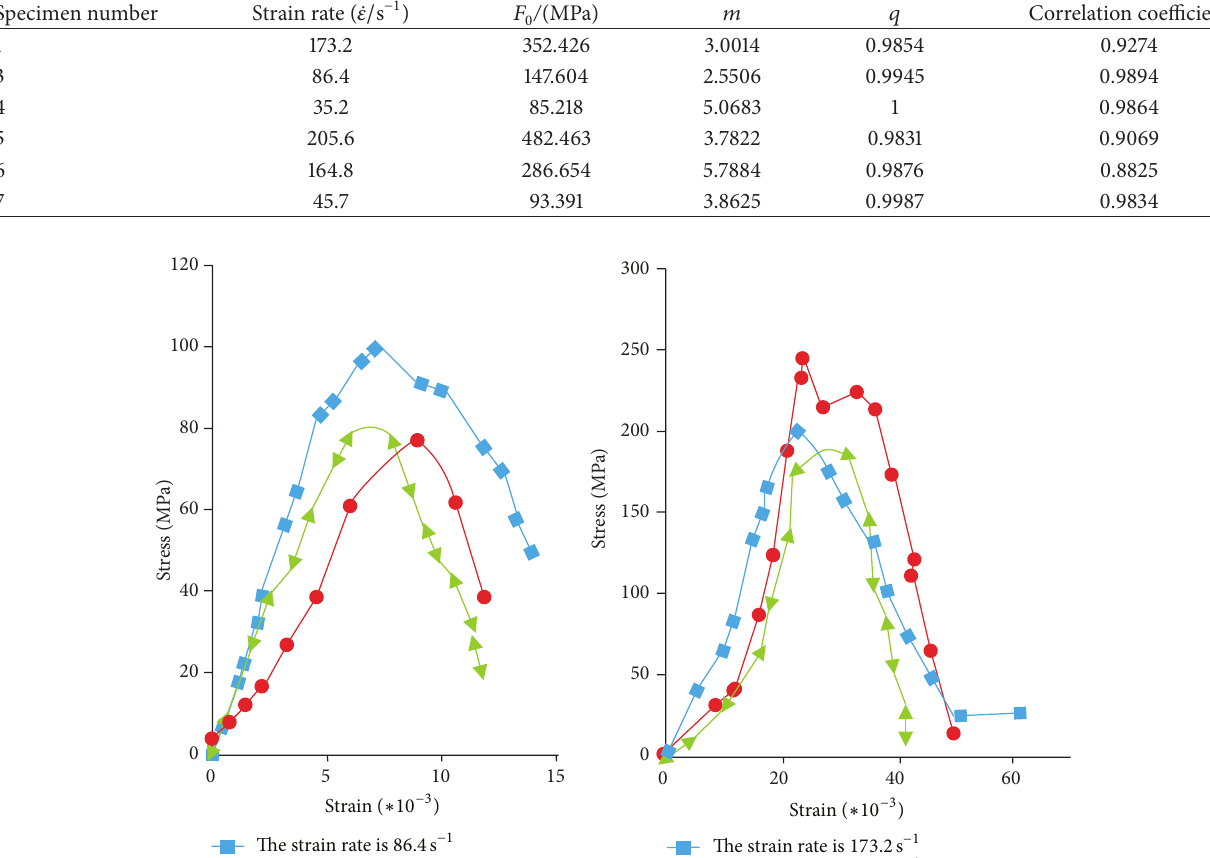
Table 1: Parameters of the shale’s dynamic statistical damage constitutive model.